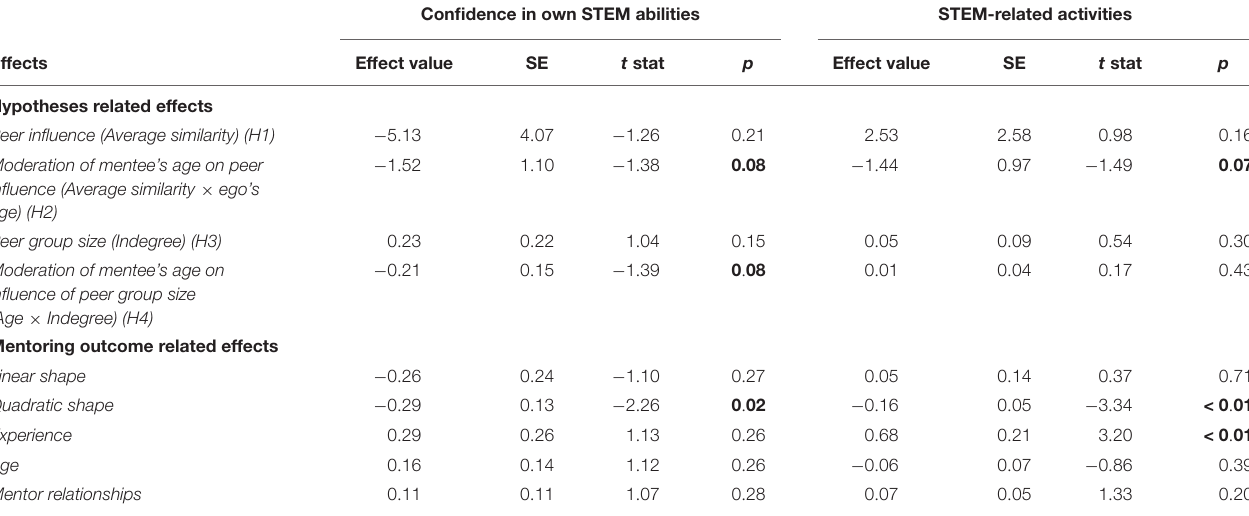
TABLE 4 | RSiena model results of both mentoring